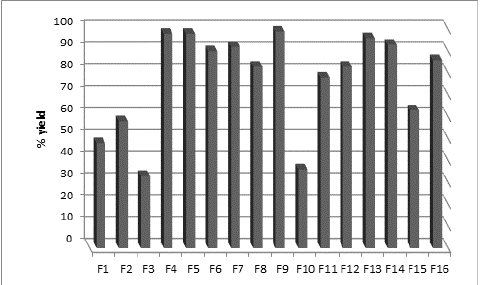
Figure 2. Percentage yield of ITZ floating microparticles.